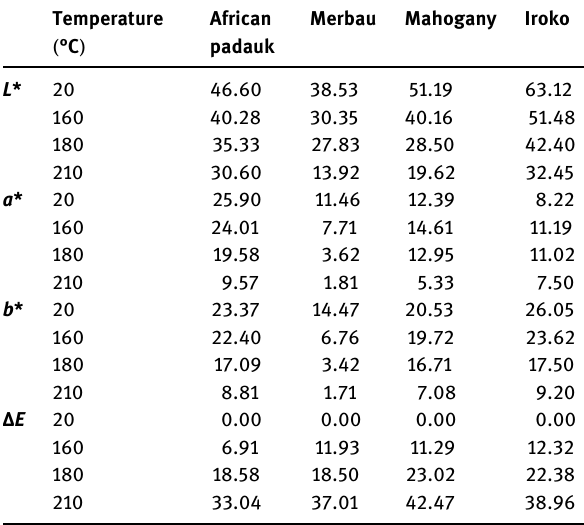
Table 2: Color space changes due to the temperature of thermal modi fi cation according to CIE Lab Temperature ( °C )